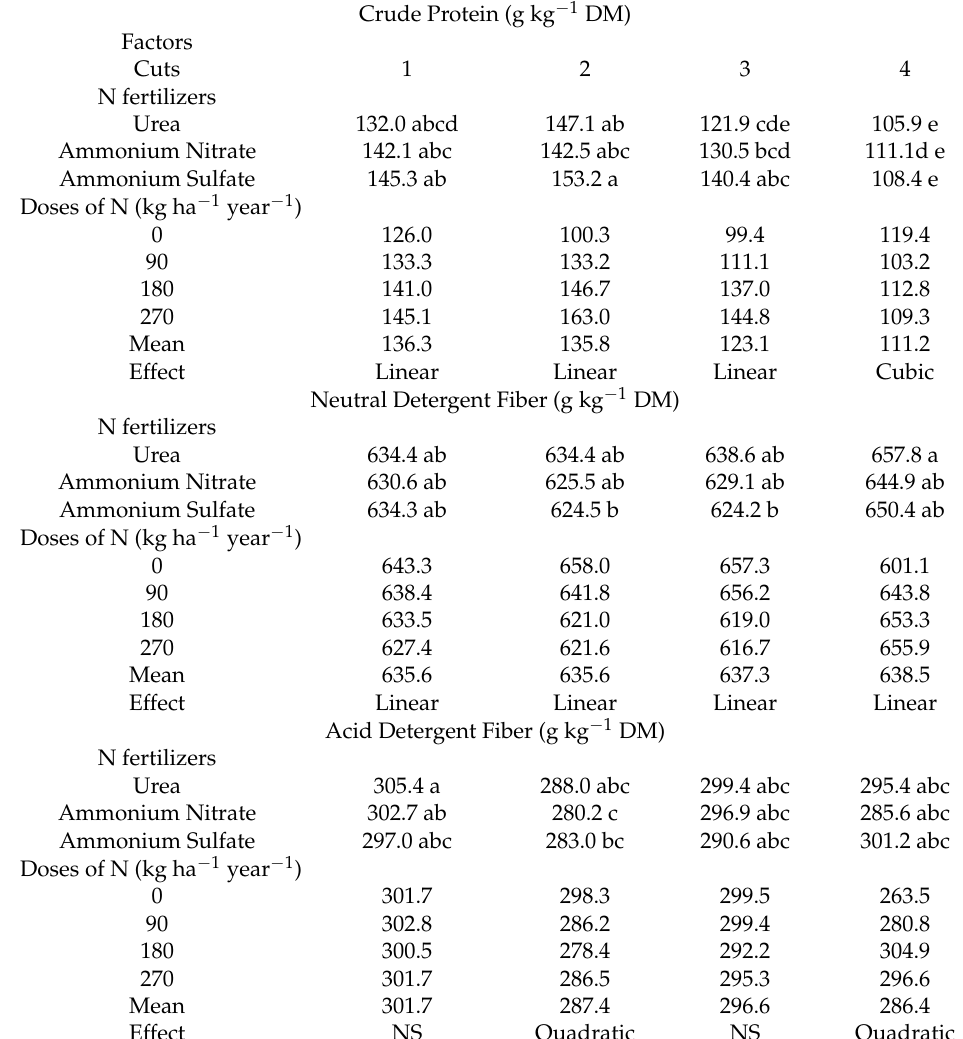
Table 2. Crude protein (CP), neutral detergent fiber (NDF), acid detergent fiber (ADF) of marandu palisade grass pastures in fertilization with different N fertilizers and